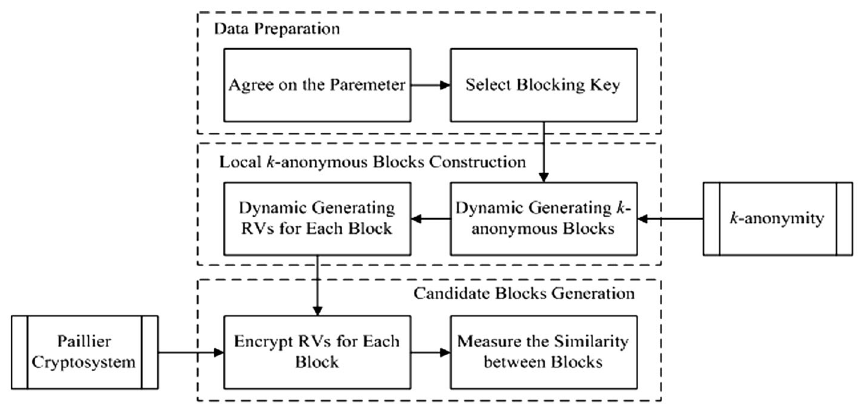
Fig. 1 Framework of our